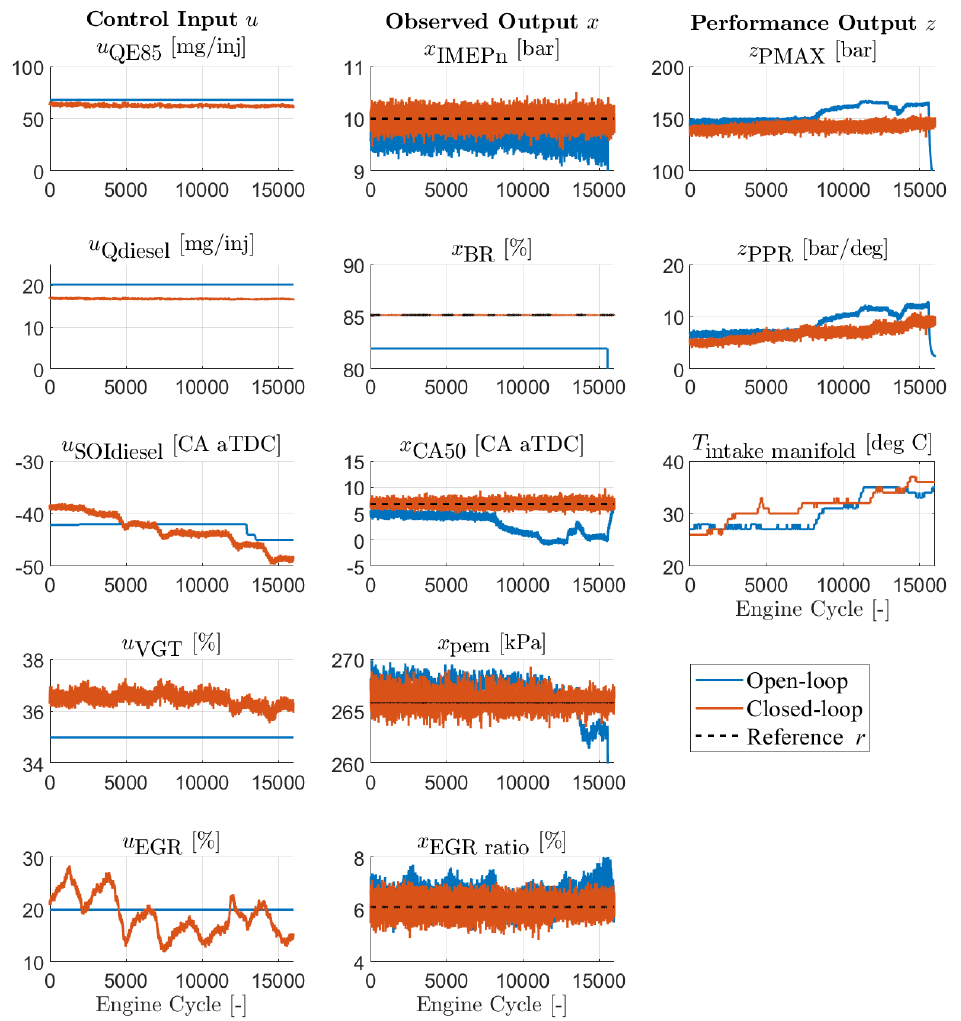
Figure 10. RCCI engine performance for disturbed intake manifold temperature T im : open-loop versus closed-loop results (PFI-to-SPI E85 mass flow ratio of